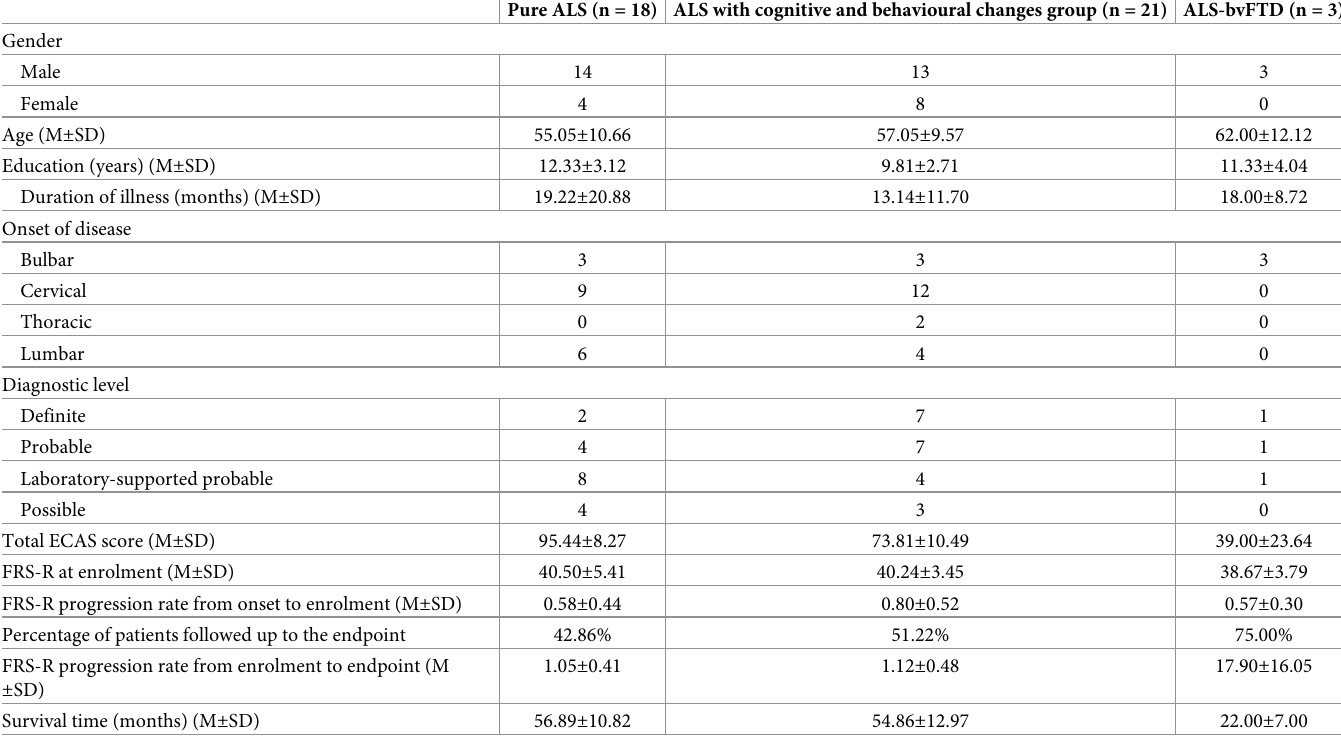
Table 3. Clinical information of the ALS patients followed up to the